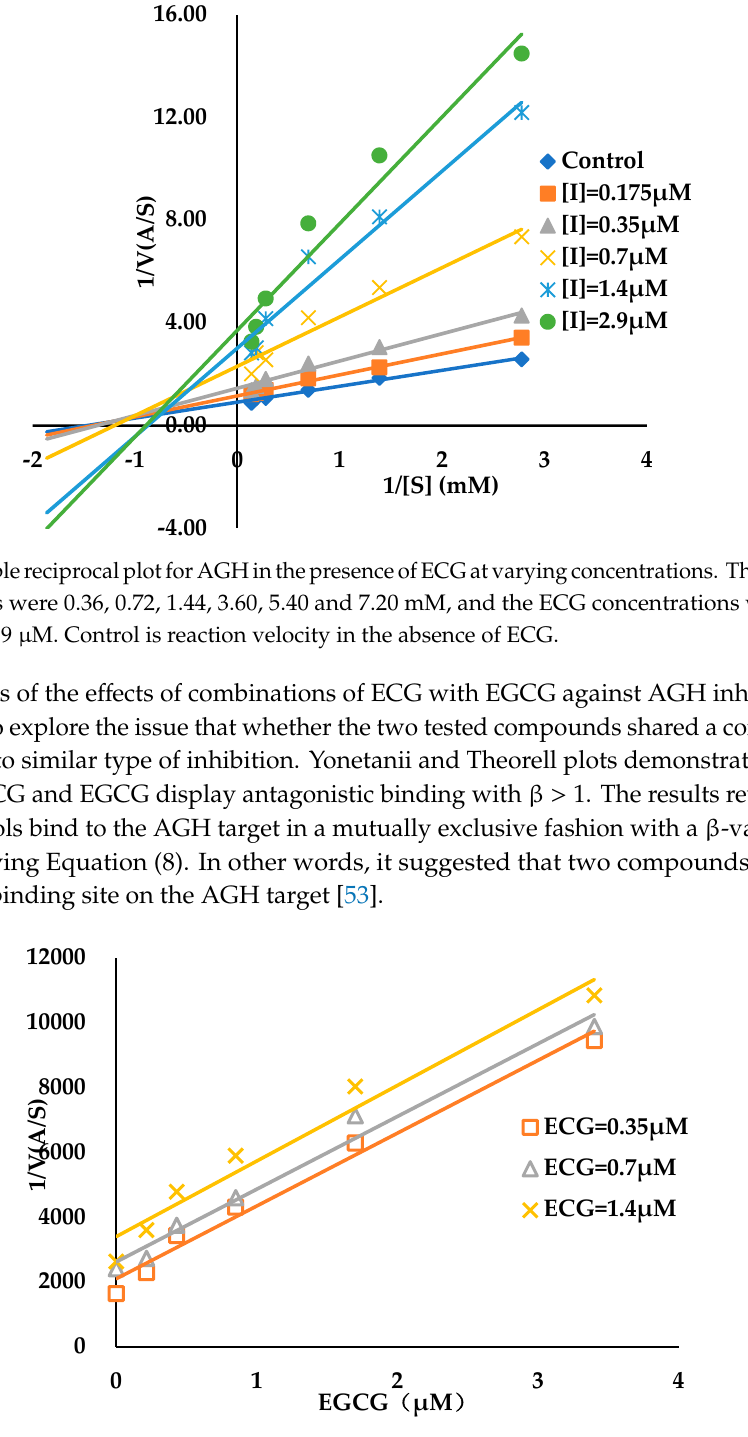
Figure 6. Exclusivity studies of compounds both ECG and EGCG. The EGCG concentrations were 0, 0.215, 0.43, 0.85, 1.7 and 3.4 µ M, and 1 / V was plotted as a function of EGCG concentrations at 0.35, 0.70 and 1.40 µ M of